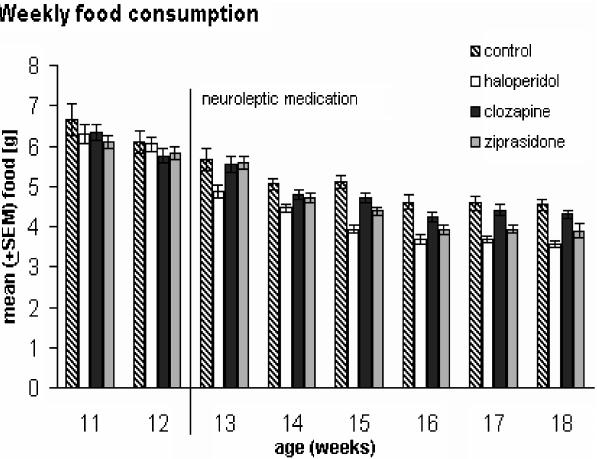
Figure 4 - Weekly water consumption based on 100 g BW of male Wistar rats: control (n = 19) and animals treated with haloperidol, clozapine, or ziprasidone (n = 20 for all groups). All animals showed slightly decreased water consumption from week 11 to week 18 but no differences before medication. Animals under haloperidol and ziprasidone medication drank less than the control and clozapine groups after 1 week of application. We found no differences between the control and clozapine groups with p # 0.008 considered